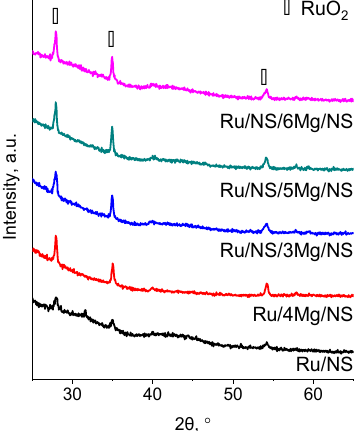
Figure 3. XRD patterns of the catalysts.